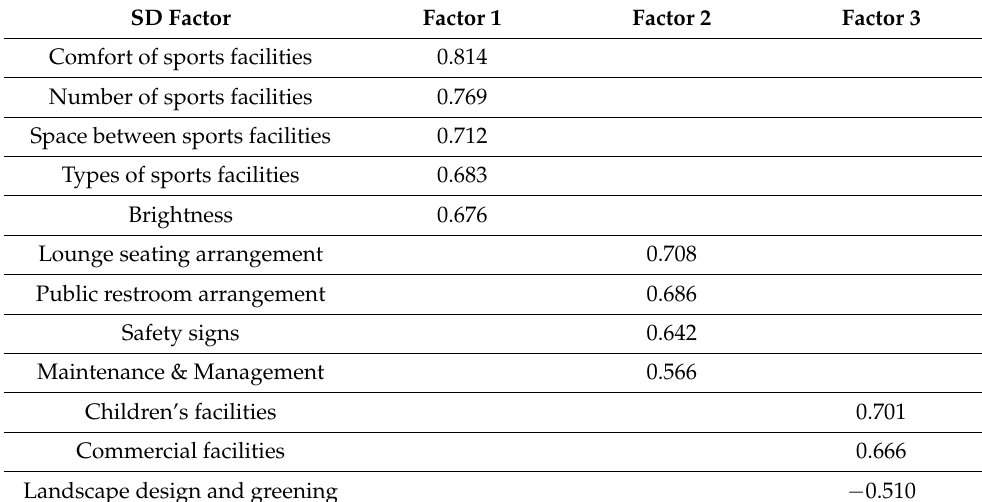
Table 5. The rotated component matrix.